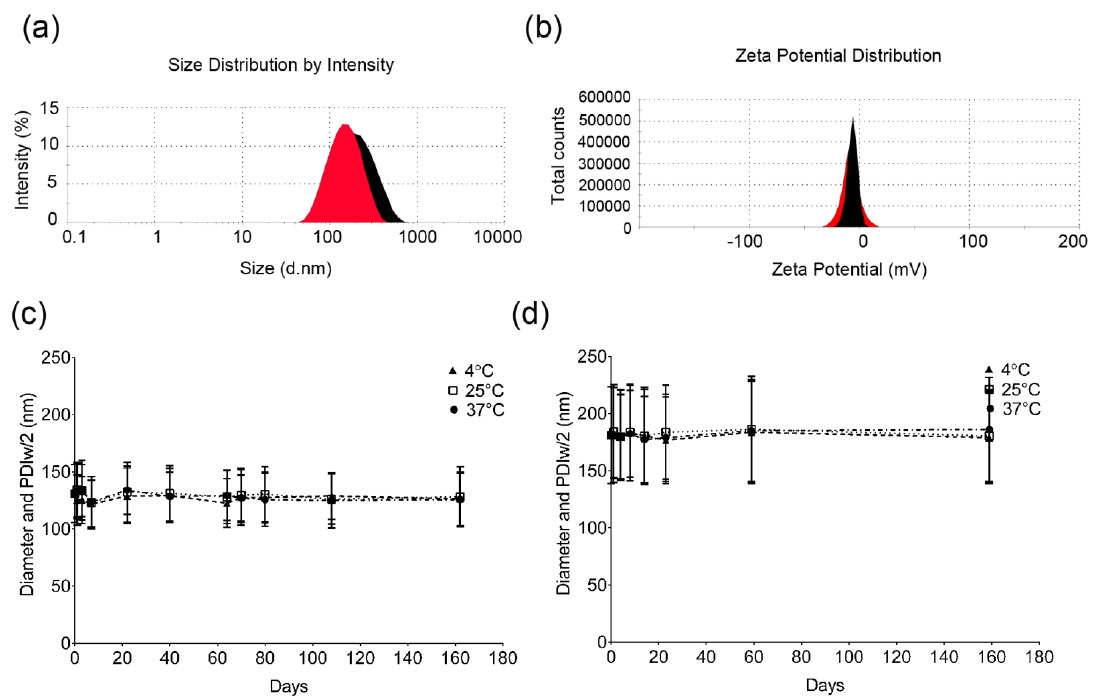
Figure 5. Physical characterization of M1 and M2 nanoemulsions using dynamic light scattering. ( a ) Representative size and ( b ) zeta potential distribution of M1 (black) and M2 (red) nanoemulsions. ( c ) Long term storage stability of M2 nanoemulsion and ( d ) M1 nanoemulsion at 4, 25 and 37 °C assessed by droplet size measurements. The error bars in panels C and D represent half width of polydispersity index